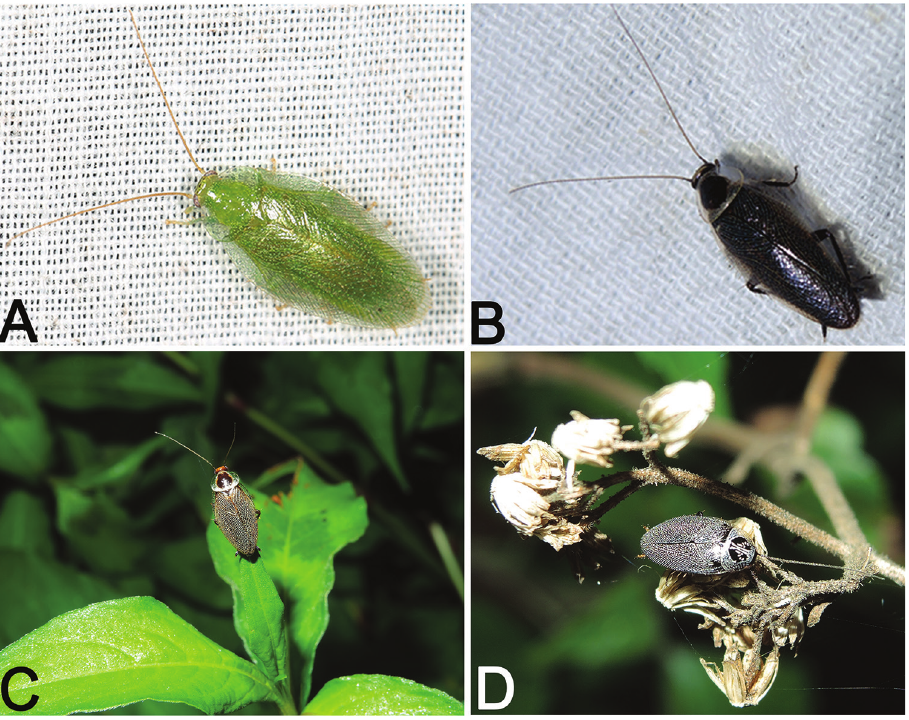
Figure 10. Sorineuchora viridis sp. n., Sorineuchora nigra and Sorineuchora shanensis in the wild. A S. viridis sp. n. holotype, photographed by Ling-Xiao Chang B S. nigra male from China, Guangxi, Long- zhou, Nonggang. 29 June 2015, light trapping, photographed by Lu Qiu C S. nigra female from China, Chongqing, Jiangjin, Mt. Simianshan, 05 June 2014, photographed by Xin-Ran Li (= Conlin McCat) D S. shanensis male from China, Yunnan, Pu’er, Simao, Meizihu, 22 May 2015, photographed by Lu